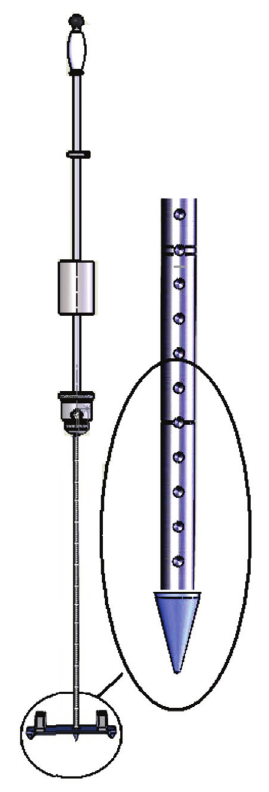
Figura 2. Método anterior: medida da profundidade na própria haste de